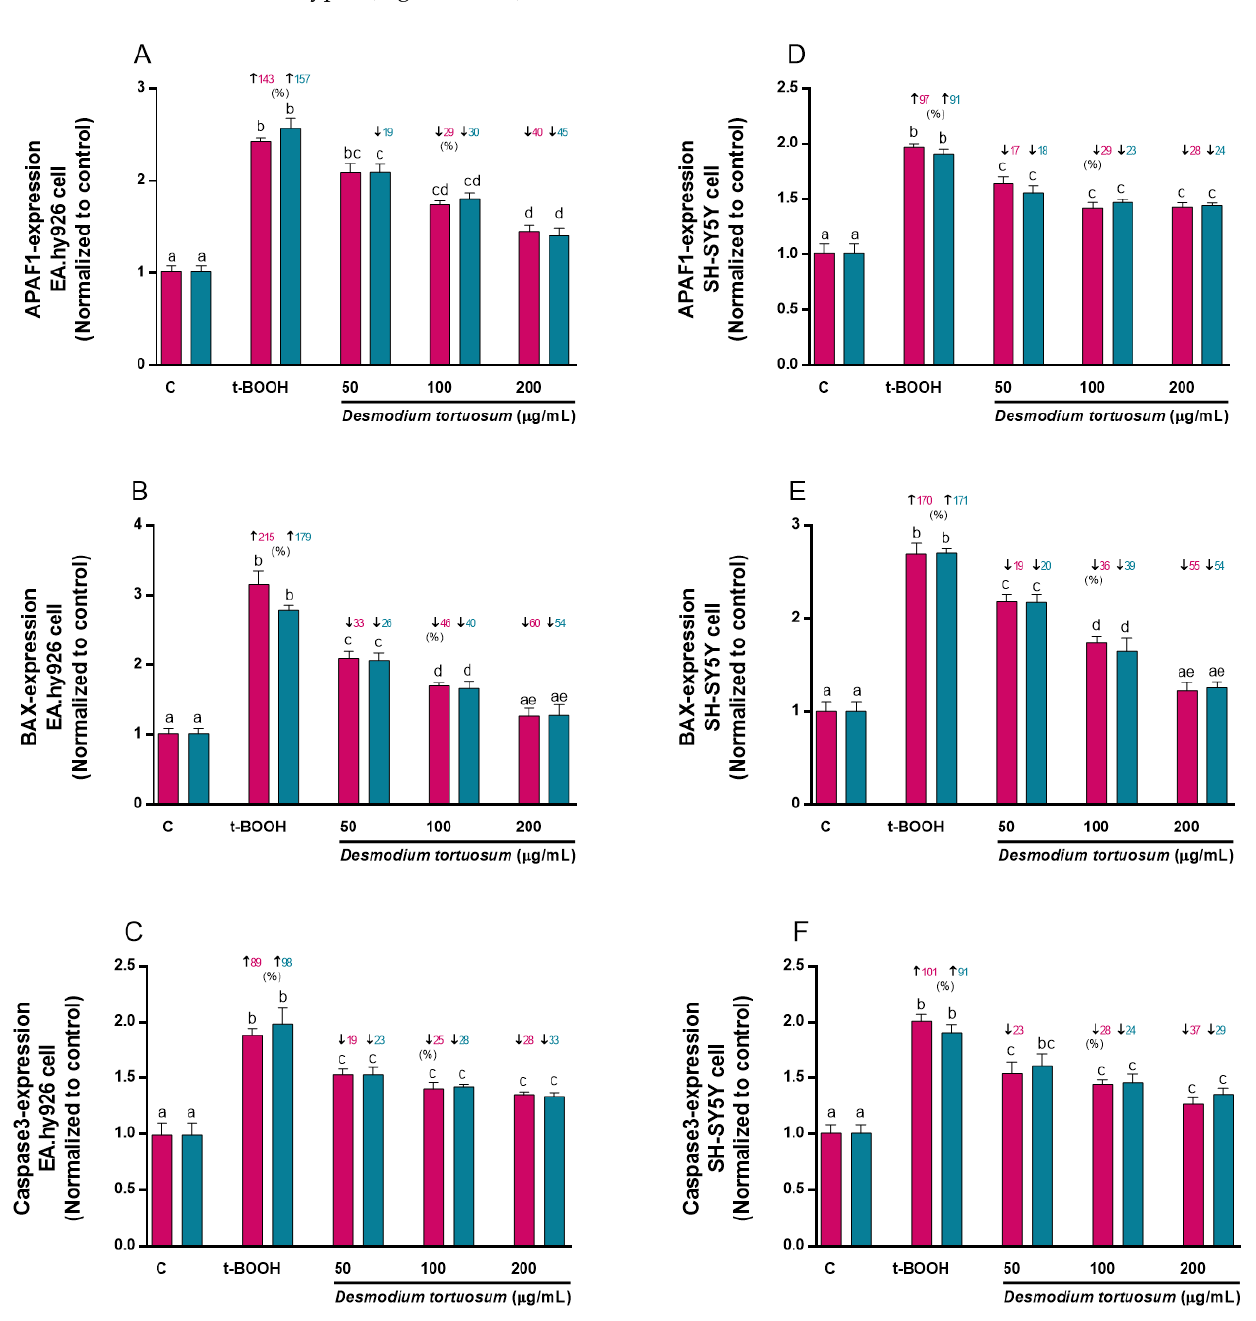
Figure 11. Effect of D. tortuosum extract (50, 100, and 200 µM) on the expression of cell death genes (APAF-1, BAX, Caspase3) in EA.hy926 ( A – C ) and SH-SY5Y ( D – F ) cells after 24 h co-treatment (red bars, █ ) and pre-treatment (blue bars, █ ) periods. The gene expression was determined as control-normalized values, and is represented the mean ± SEM of four independent experiments. a,b,c,d,e Different letters show significance between groups at p < 0.05. ↓ represents percentage decrease or ↑ represent percentage increase with respect to control or with respect to t-BOOH.